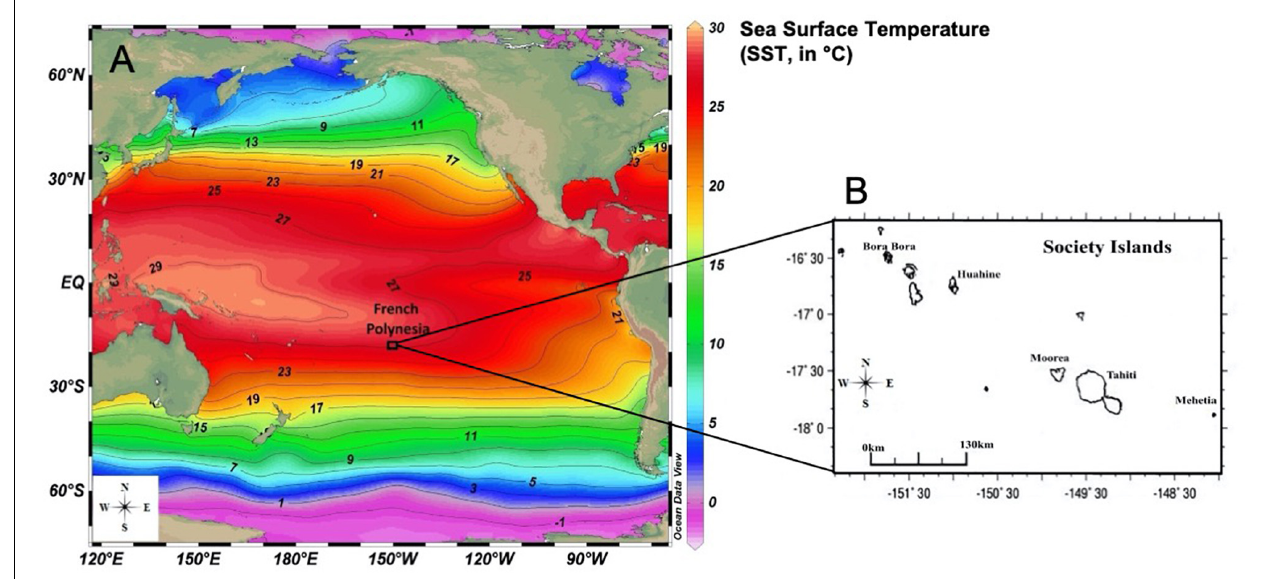
FIGURE 1 | (A) Present mean Sea Surface Temperature (SST) distribution in the Pacific region, with the location of French Polynesia indicated (where the Society Islands are located); (B) a close-up map of Society Islands where samples were